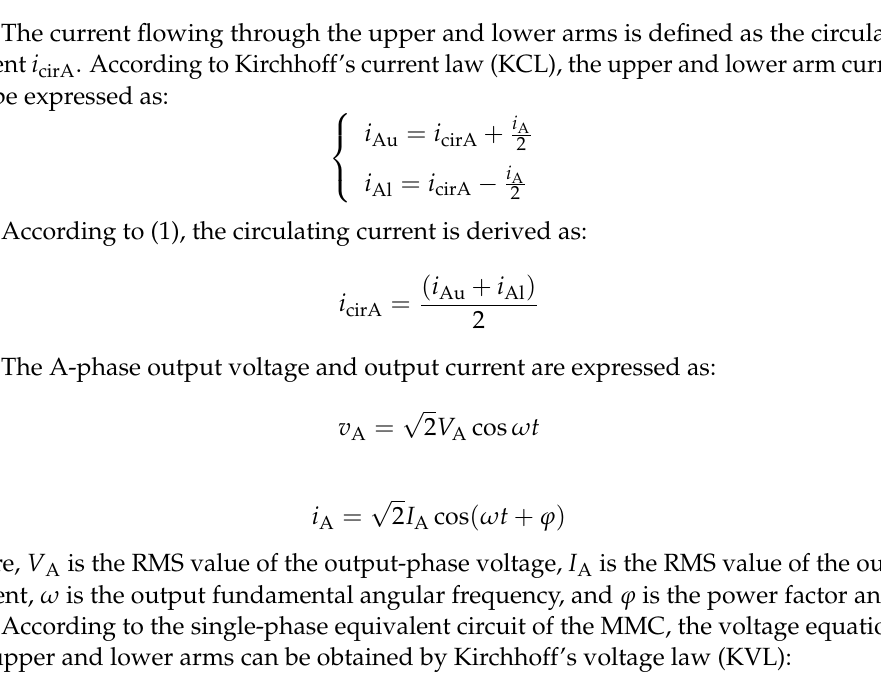
Figure 3. The single-phase equivalent circuit of the MMC.